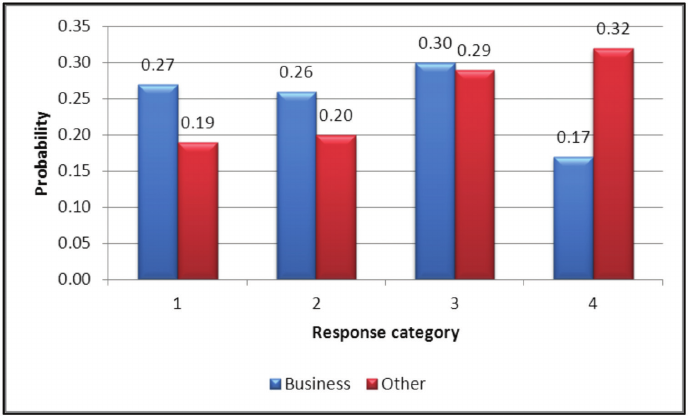
Figure 4: Response category probabilities – Price of the ticket (purpose of travel) The estimated response category probabilities of business and other passengers